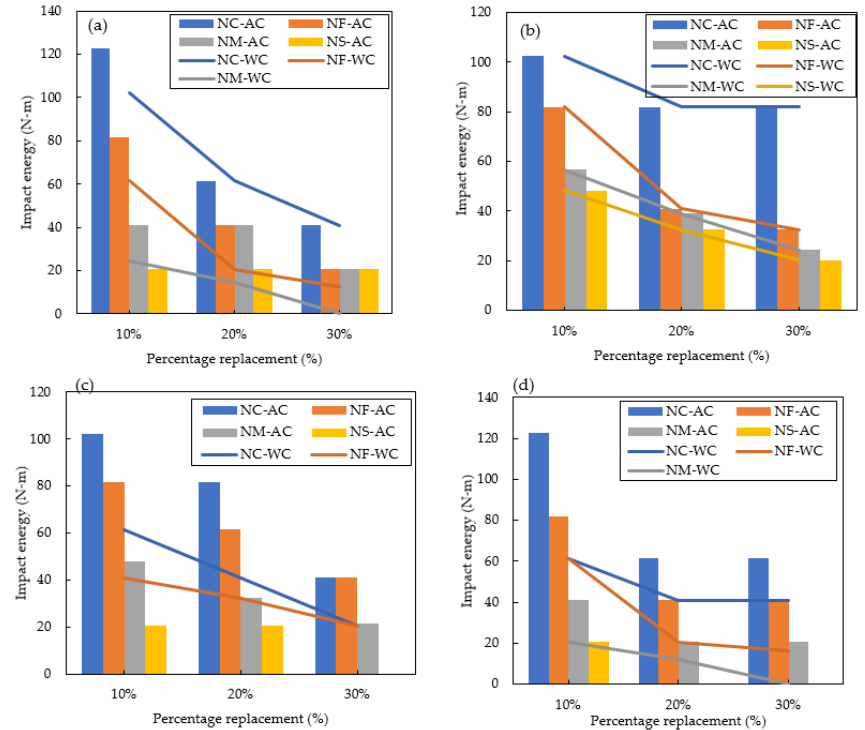
Figure 9. Impact energy versus percentages of nanomaterials in various grades at 750 °C: ( a ) M20; ( b ) M30; ( c ) M40; ( d ) M50.